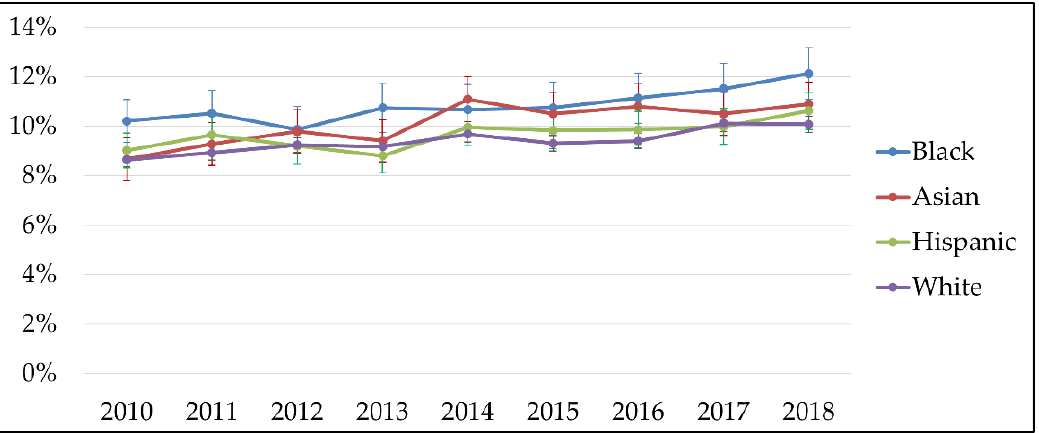
Figure 2. Proportion of postpartum anxiety or depression, by race/ethnicity, 2010 – 2018. Between 2010 and 2018, rates of NICU admission increased among all infants, regard- less of race/ethnicity, including: Black infants from 10.2% (95% CI: 9.3% – 11.1%) to 12.1% (95% CI: 11.1% – 13.2%); Asian infants from 8.7% (95% CI: 7.8% – 9.5%) to 10.9% (95% CI: 10.0% – 11.8%); Hispanic infants from 9.0% (95% CI: 8.3% – 9.7%) to 10.6% (95% CI: 9.9% – 11.4%); and white infants from 8.6% (95% CI: 8.3% – 8.9%) to 10.0% (95% CI: 9.7% – 10.4%; Figure 3).